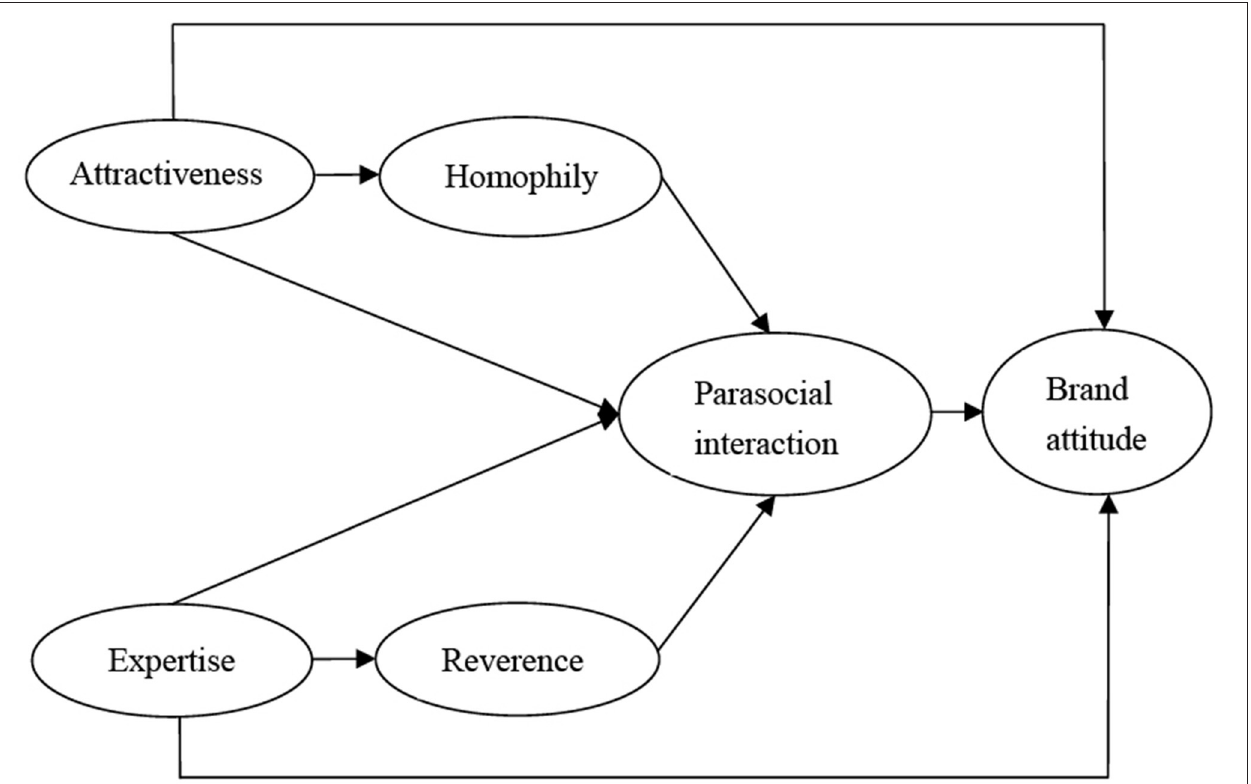
FIGURE 1 | Conceptual model of the endorsement